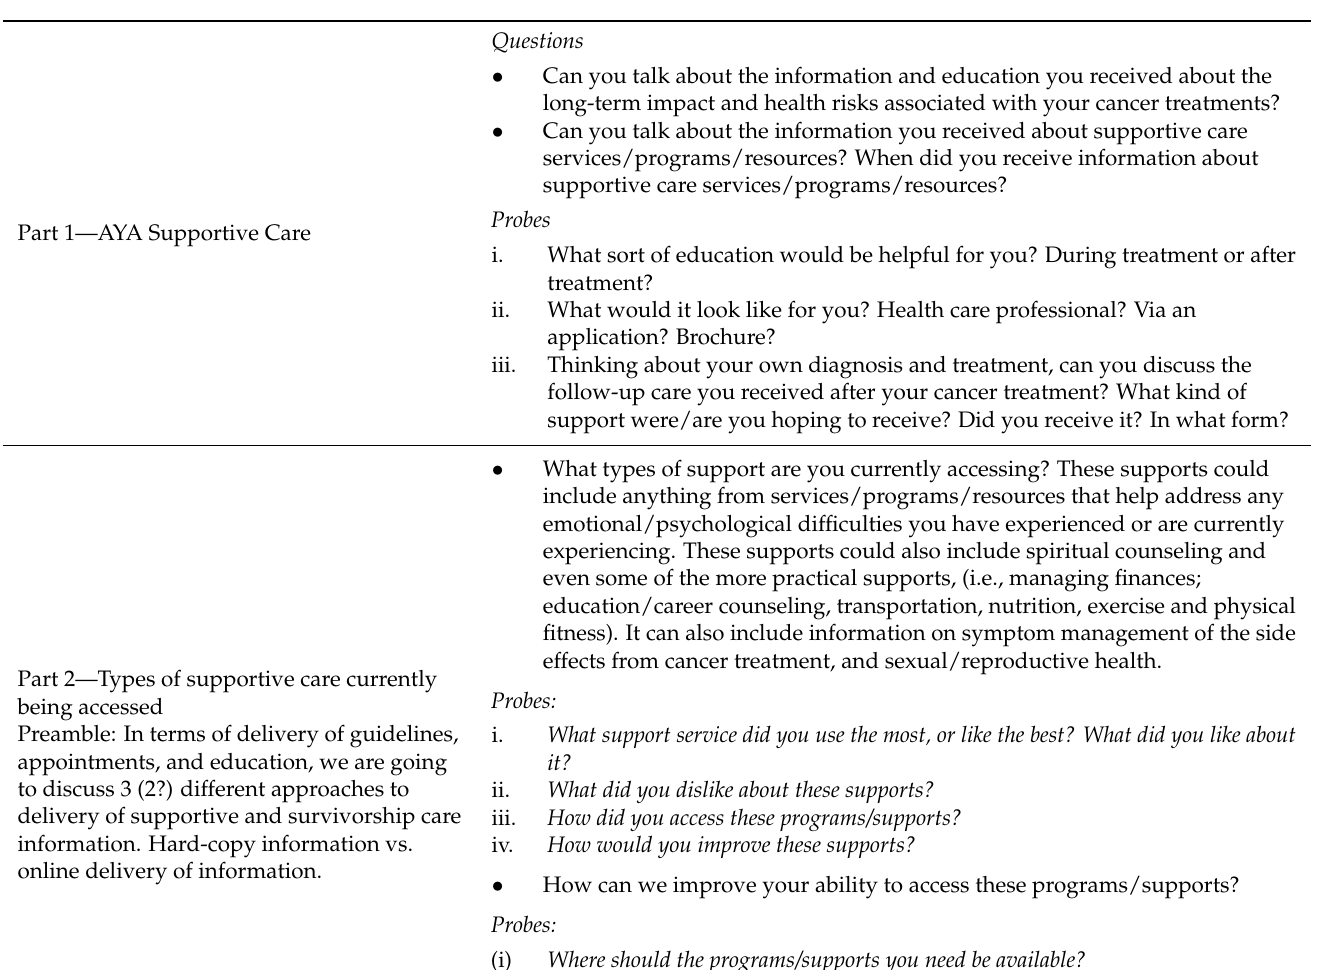
Table 1. Focus group script: themes, questions, and